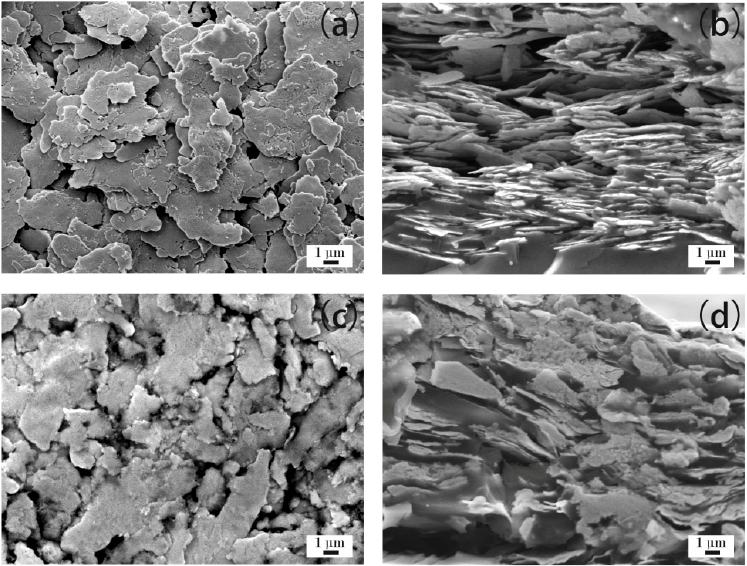
Figure 10. ECAs filled with 80 wt % Ag flakes. ( a ) ECAs fabricated by the powder spraying process; and ( b ) cross sections of ECAs fabricated by the powder spraying process; ( c ) ECAs fabricated by the conventional process; and ( d ) cross sections of ECAs fabricated by the conventional process.